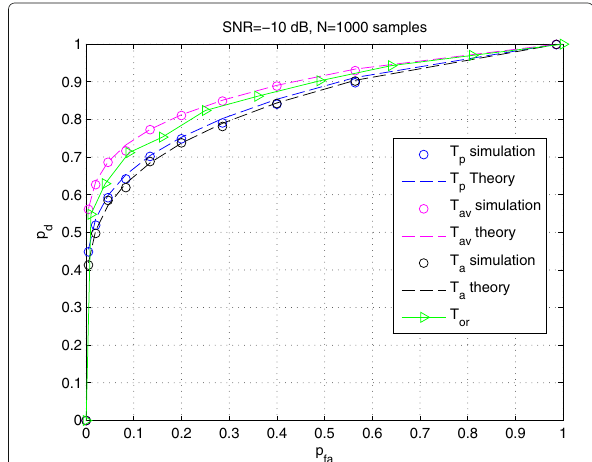
Fig. 4 Simulated vs. analytical results over Rayleigh fading channel, N s = 3